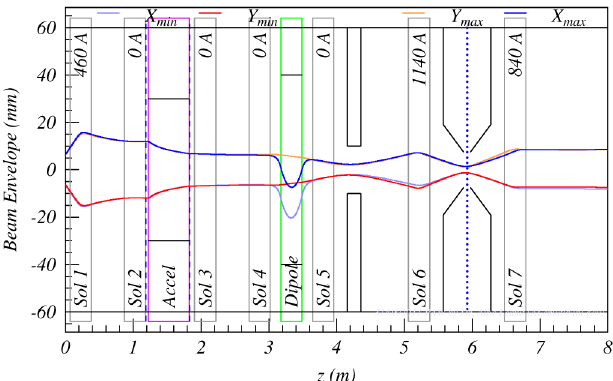
FIG. 12. 4 He þ 400 keV 12.5 mA (350 kV post acceleration, 5 kW, gap width 550 mm, screening voltage (cid:1) 5 kV , neutraliza- tion 90%) beam envelopes through the gas-jet target station beam line. Between the two dashed blue vertical lines (over- lapped on the focal elements symbols), the beam is treated at full space charge (length 647.7